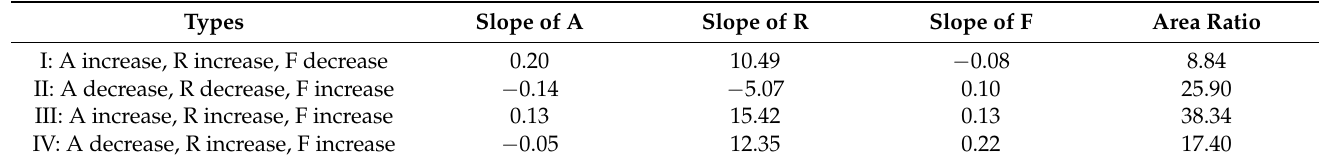
Table 3. Overlapping statistics among soil erosion modulus, rainfall erodibility, and vegetation coverage in the TRHR, China 1